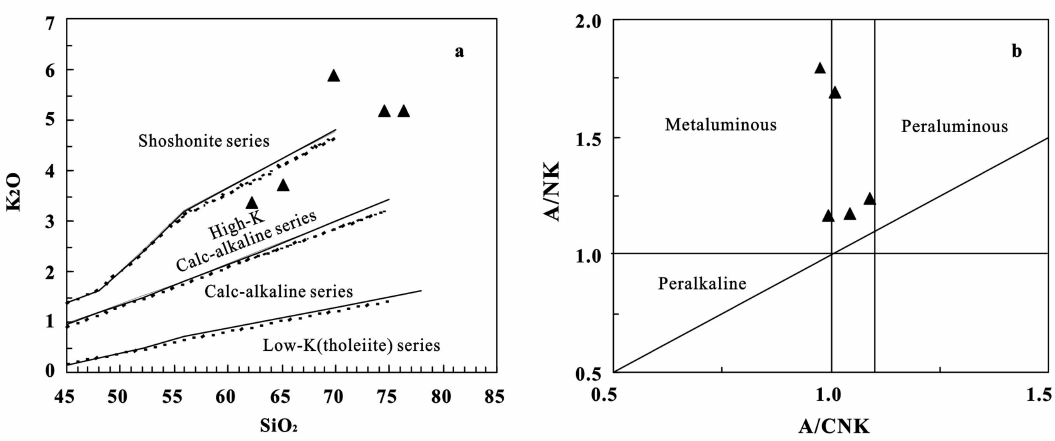
Figure 5. SiO 2 –K 2 O diagram ( a ) and aluminous index diagram ( b ) for Biotite granite (after Peccerillo and Taylor